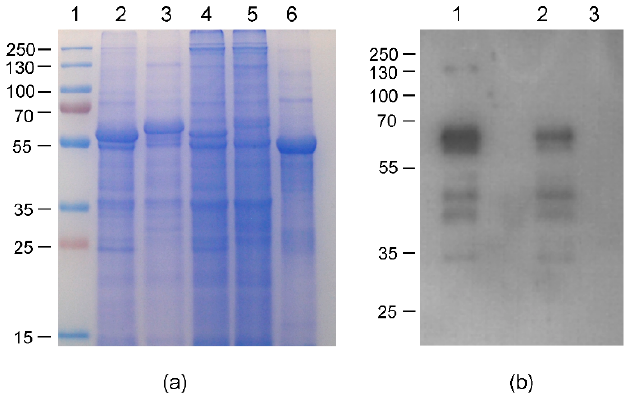
Figure 8. Relative efficiencies of PVX- and CPMV-based vectors; ( a ) Coomassie brilliant blue stained gel of 1.5 mg fresh weight (FW) and ( b ) Western blot of proteins isolated form N. benthamiana plants on day 4 post infiltration and separated by SDS-PAGE and analysed with anti-M2e Ab; ( a ) 1. Molecular weight marker (kDa); lanes 2–5, total soluble proteins isolated from zones of leaves infiltrated with agrobacteria carrying recombinant vectors pEff-HEV 110–610 (lane 2), pEff-M2 HEV 110–610 (lane 3), pEAQ-HEV 110–610 (lane 4) and pEAQ-M2 HEV 110–610 (lane 5). Lane 6 total soluble proteins isolated from noninfiltrated zone; ( b ) Lanes 1–3, total soluble proteins isolated from zones of leaves infiltrated with agrobacteria carrying recombinant vector pEff-M2 HEV 110–610 (lane 1), pEAQ-M2 HEV 110–610 (lane 2) and total soluble proteins isolated from noninfiltrated zone (lane 3).